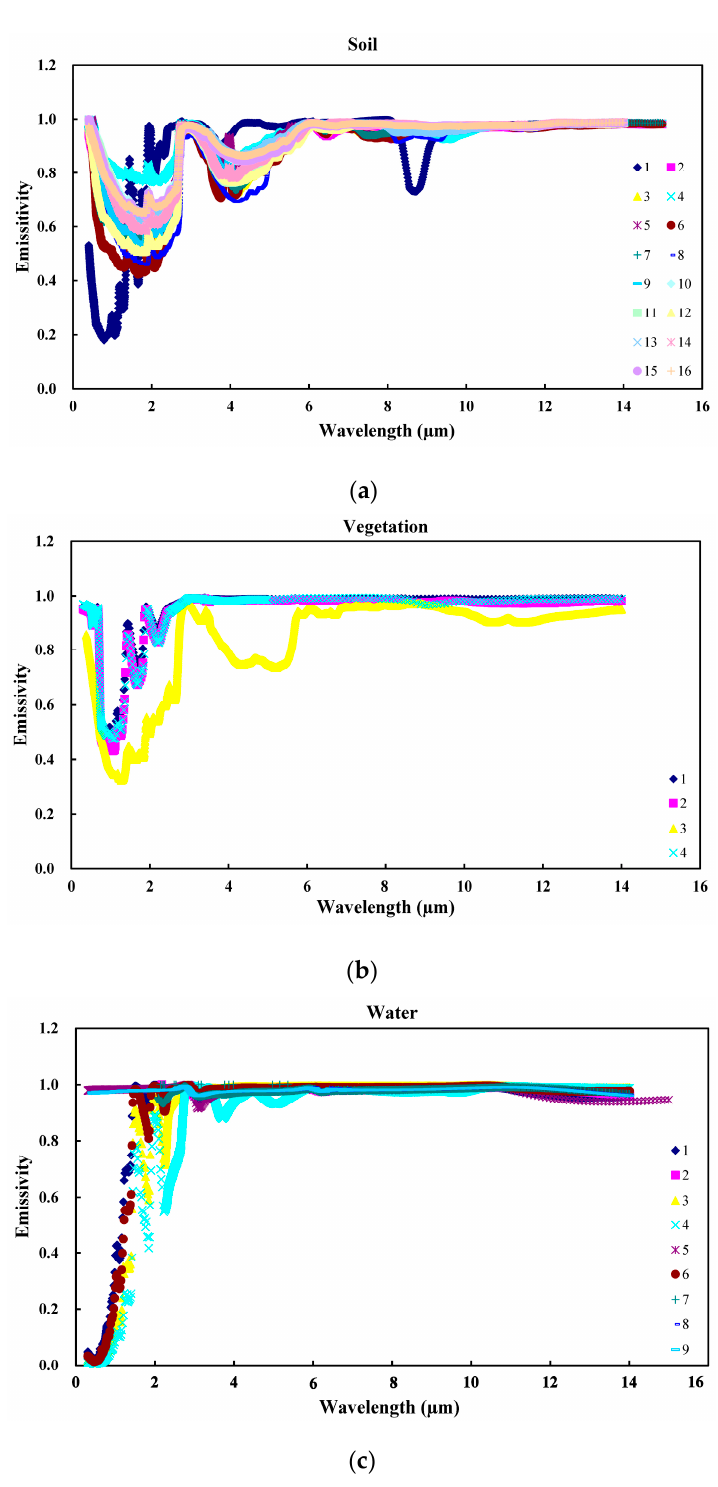
Figure 4. Measured reflectance of various soil ( a ), vegetation ( b ), and water ( c ) samples.